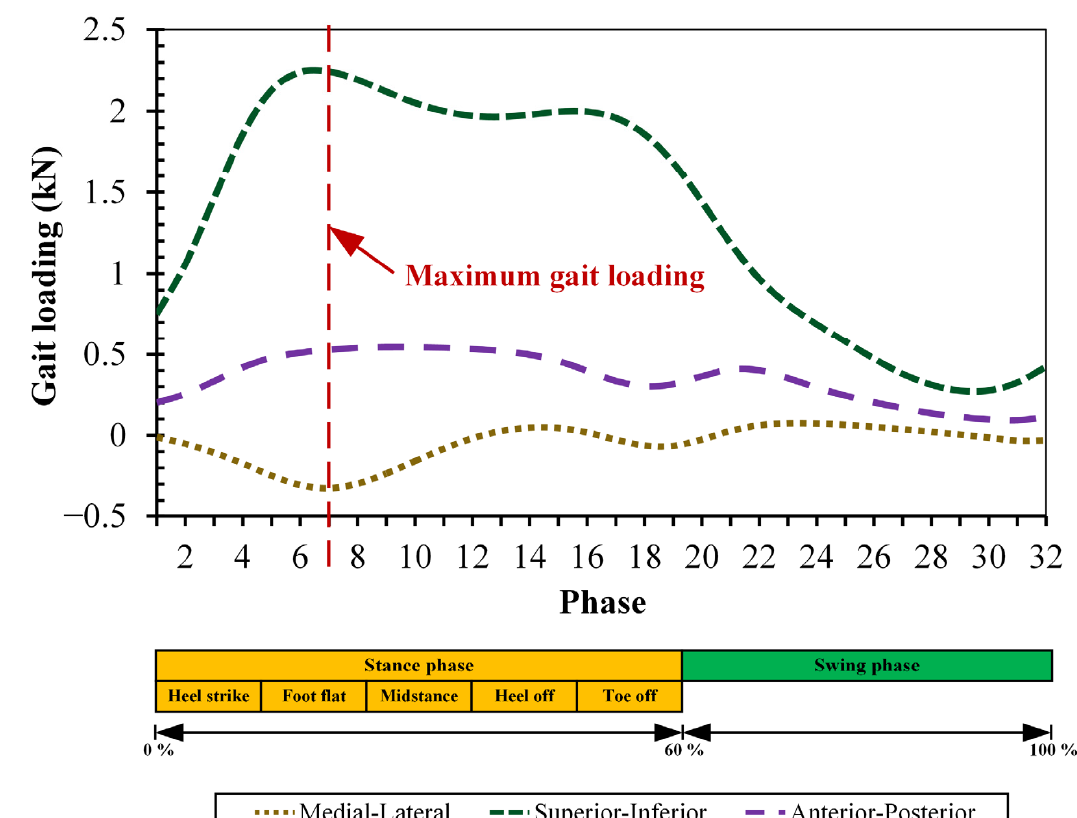
Figure 3. Gait loading simulated on the hard-on-hard bearing of total hip prosthesis [35].